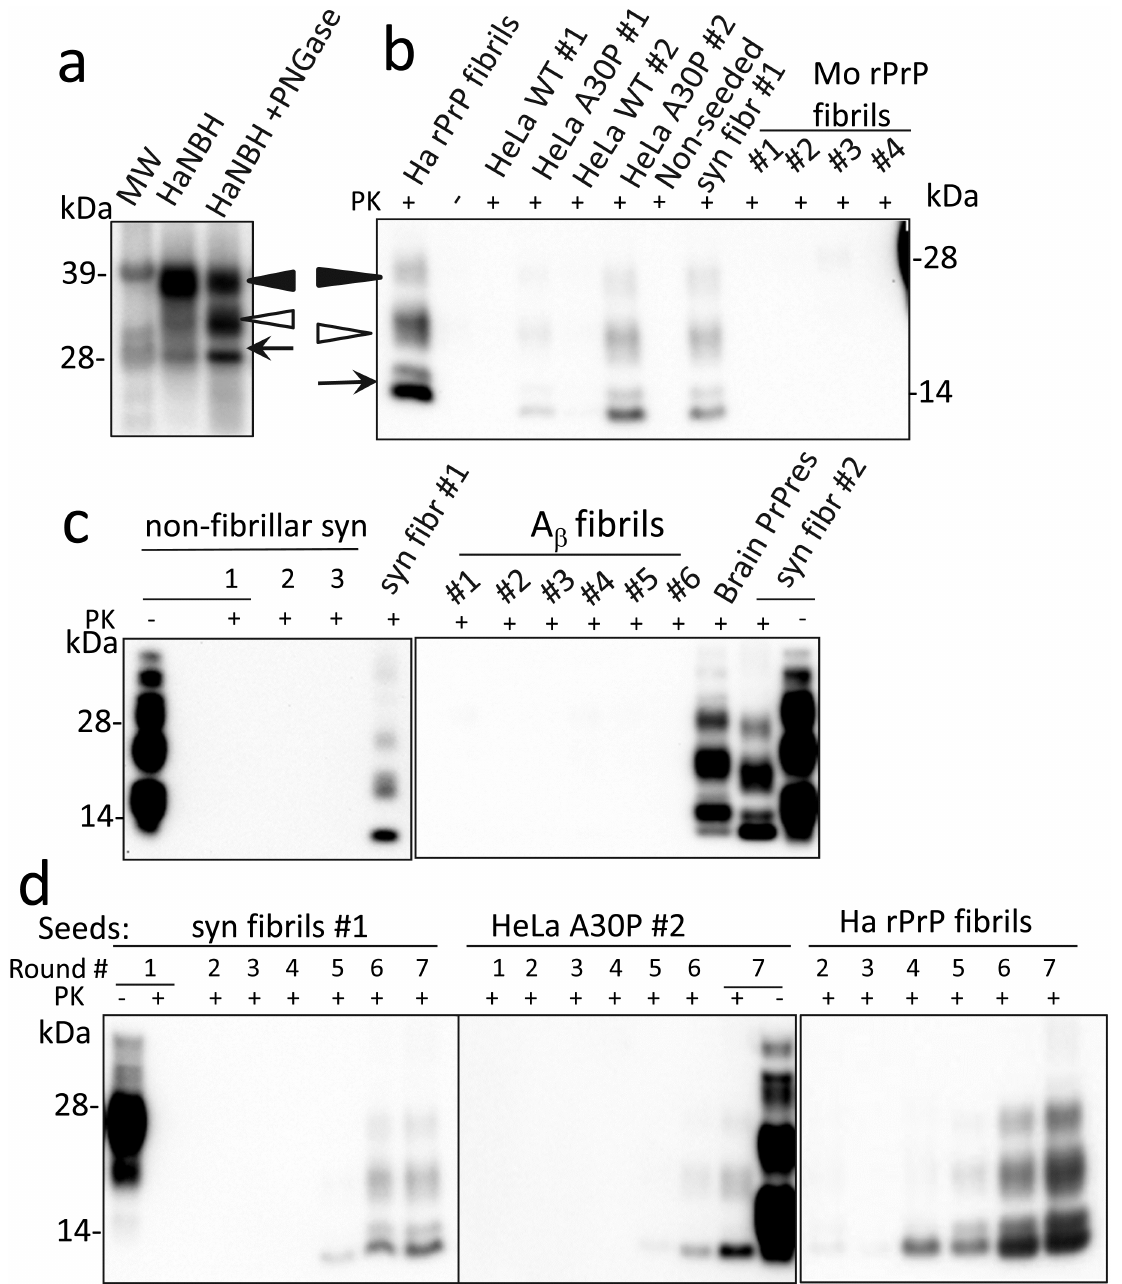
Fig 1. Cross-seeding of PrP C misfolding and replication in dgPMCAb. a Analysis of the glycoform ratios of PrP C from Syrian hamster normal brain homogenate (HaNBH) before and after treatment with PNGase F. Black and white trianglesmark di- and monoglycosylated glycoforms, respectively,whereasarrows mark the unglycosylated form. b and c Serial dgPMCAbreactions were seededas labeledwith (i) lysates of HeLa cells expressingWT α -synuclein(HeLa WT) or A30P mutant (HeLa A30P) and cultured under two conditions (#1, #2) as describedin Methods; (ii) amyloid fibrils produced in vitro from recombinant α -synuclein from two sources (syn fibrils #1, #2 as describedin Methods); (iii) mouse rPrP amyloidfibrils produced in vitro in 0, 0.1, 0.5, or 2.5M GdnHCl (Mo rPrP fibrils #1, #2, #3, #4, respectively); (iv) non-fibrillar α -synuclein(non-fibr); or (v) A β fibrils produced in vitro using six different protocols as describedin Methods (A β fibrils, #1–#6). As a control for cross-contamination, non-seeded dgPMCAbreactionswere conductedin parallel(non-seeded). Seven serial dgPMCAbrounds with 10-fold dilutionsbetween rounds were conductedand the products of the seventh round were treated with PK and analyzedby Western blots using SAF- 84 antibodies. As references, dgPMCAb-derived PrPres formed in serial dgPMCAb seeded with hamster rPrP fibrils produced in vitro in 0.5 M GdnHCl (Ha rPrP fibrils, panel b ) or brain- derived PrPres from animalsinoculated with hamster rPrP fibrils are